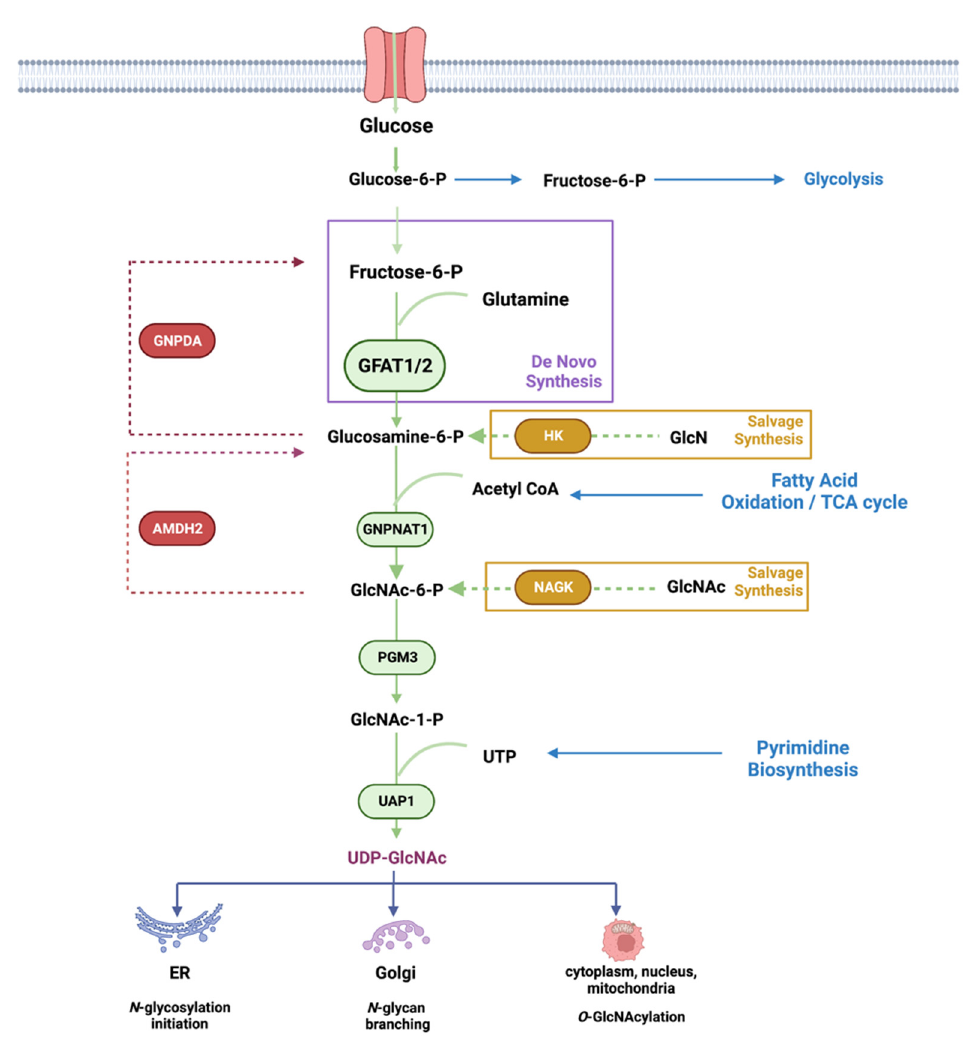
Figure 1. The hexosamine biosynthesis pathway. The de novo synthesis of UDP-GlcNAc is catalyzed by GFAT1/2, which utilizes glutamine and fructose-6-phosphate (a glycolytic metabolite) as substrates to generate glucosamine-6-phosphate. Subsequent reactions are catalyzed by metabolic enzymes to eventually generate UDP-GlcNAc, a metabolite that is used for protein N -glycosylation, N -glycan branching, and O -GlcNAcylation. UDP-GlcNAc can also be generated by using the salvage nutrients glucosamine (GlcN) and N -acetylglucosamine (GlcNAc). N -glycosylation occurs in the endoplasmic reticulum (ER), wherein a high mannose glycan is preassembled onto two successive UDP-GlcNAc moieties that are attached to a dolichol embedded in the ER membrane. This precursor oligosaccharide is then transferred en bloc to Asn residues within Asn-X-Ser/Thr motifs of nascent secretory or membrane- bound polypeptides. UDP-GlcNAc is further used for N -glycan remodeling or